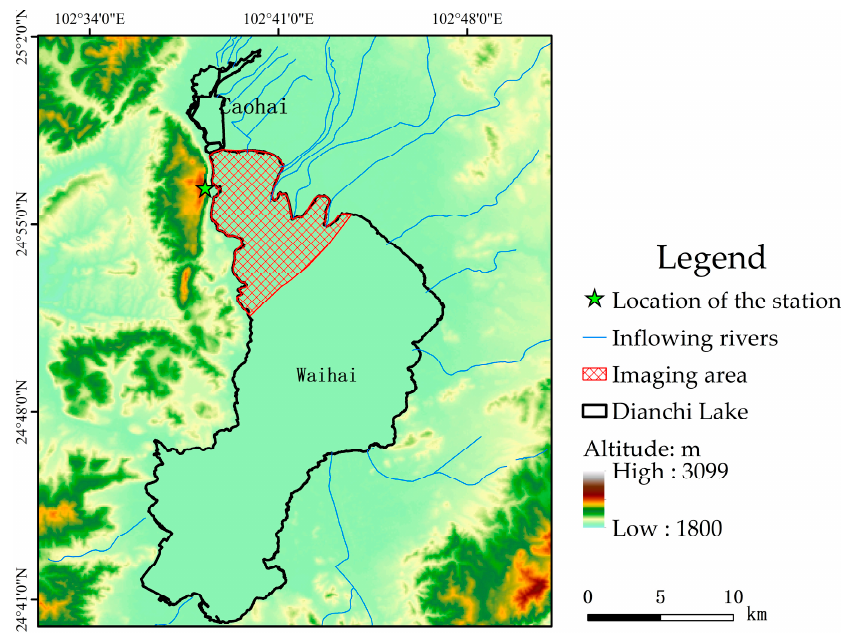
Figure 1. Location and imaging area of the ground-based imaging remote-sensing station used to observe Dianchi Lake.